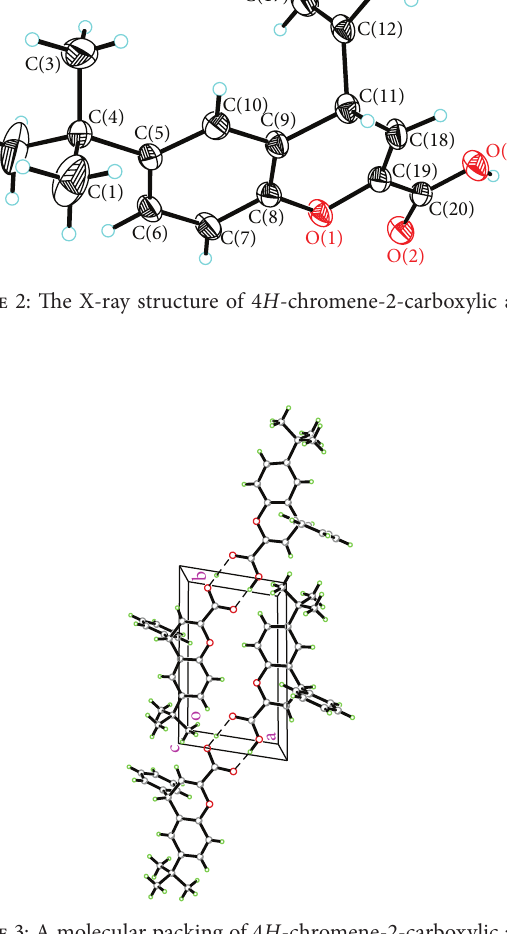
Figure 3: A molecular packing of 4 H -chromene-2-carboxylic acid 8a